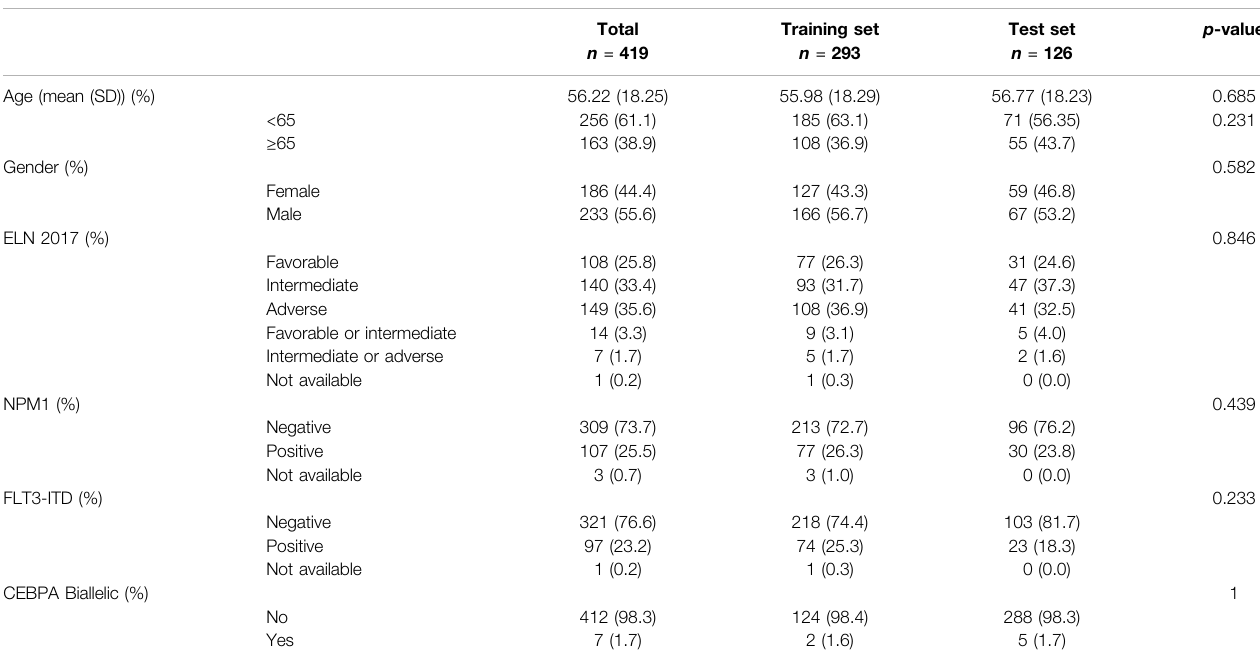
TABLE 1 | Patients ’ basic characteristics in BEATAML1.0